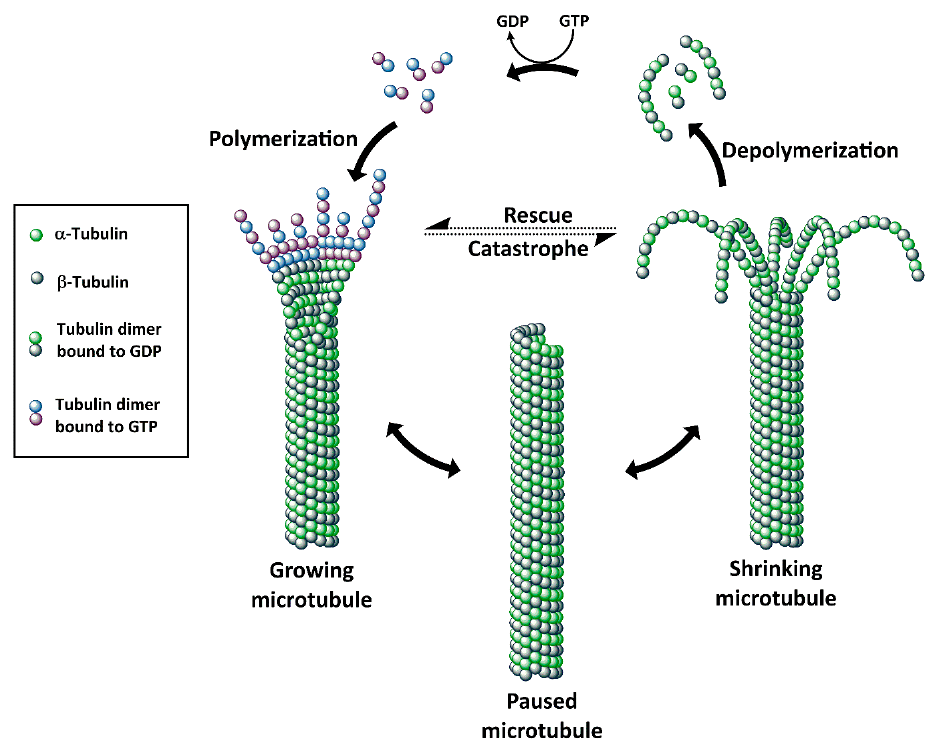
Figure 3. Structure, polymerization and depolymerization of microtubules.